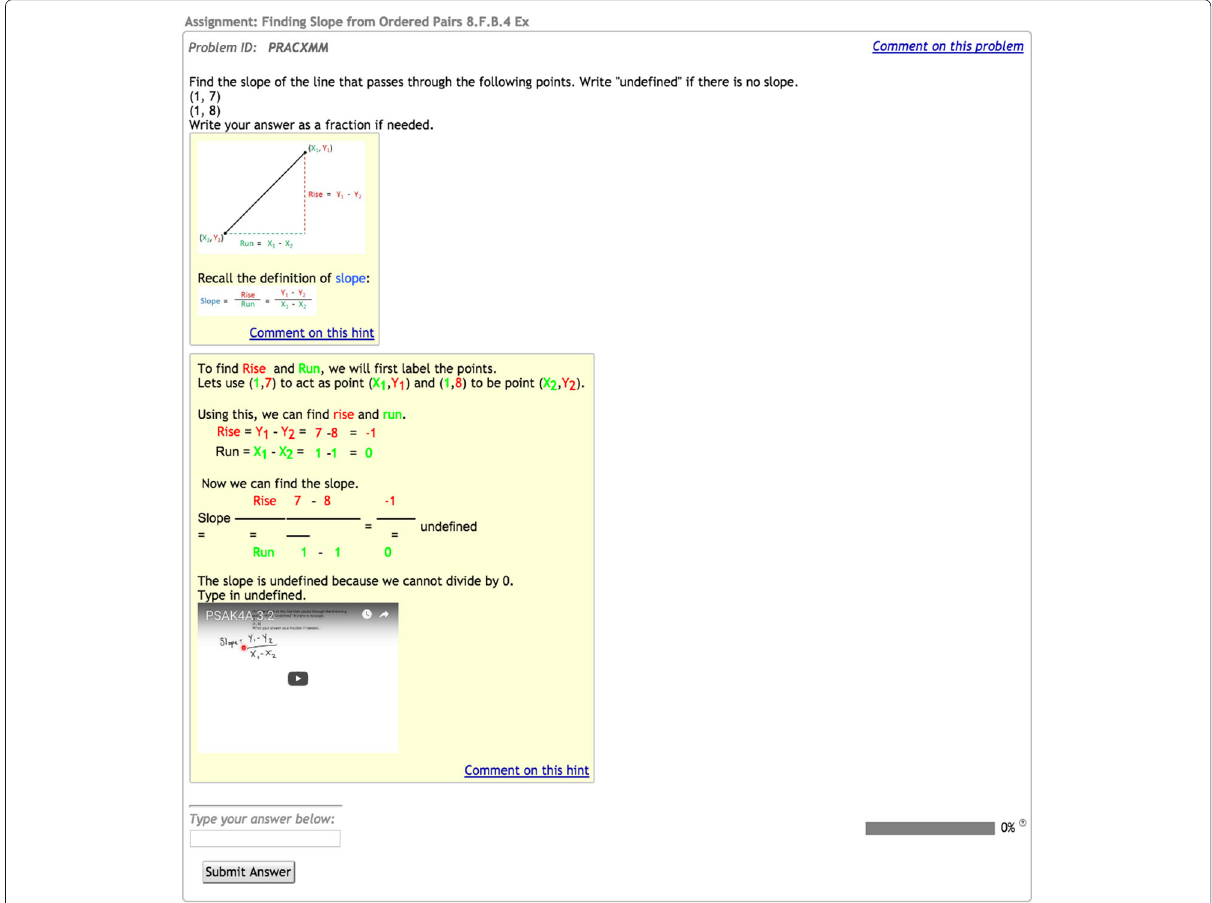
Fig. 1 No Hints-early screenshot. An example question from the no-hints-early condition, showing a bottom-out hint